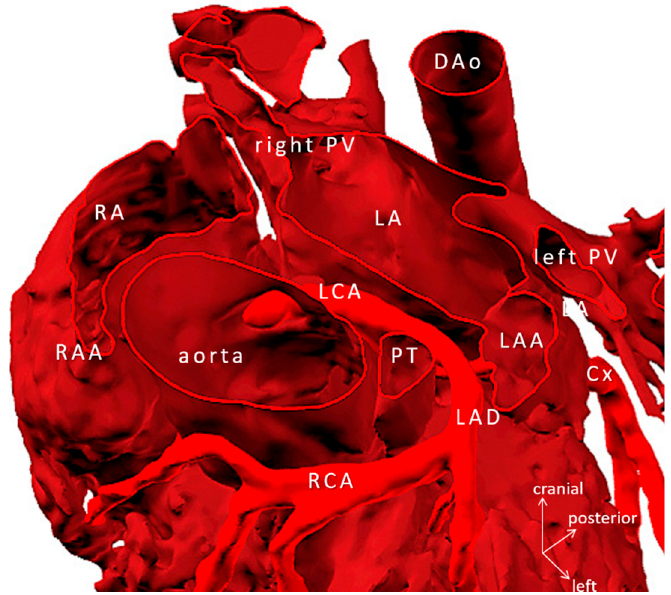
Figure 6. Virtual 3D model tetralogy of Fallot, pulmonary atresia with anomalous origin of the right coronary artery from left anterior descending branch of the left coronary artery (Case 5). Ascending aorta is transected at the level of the sinotubular junction. Note: knowledge of the exact course of the aberrant coronary artery is crucial in avoiding injury during the placement of the right ventricle to pulmonary bifurcation conduit. Abbreviations: Cx: circumflex branch of the left coronary artery, DAo: descending aorta, LA: left atrium, LAA: left atrial appendage, LCA: mainstem left coronary artery, LAD: left anterior descending coronary artery, PT: pulmonary trunk, PV: pulmonary vein, RA: right atrium, RAA: right atrial appendage, RCA: right coronary artery.